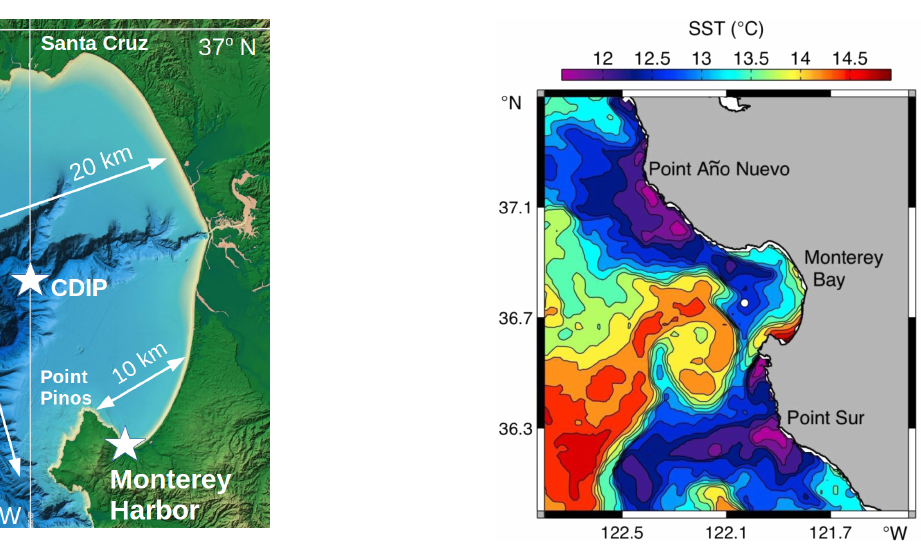
Figure 2. Sea surface temperature image from 13 October 2008 de- picting the persistent mesoscale anti-cyclonic gyre offshore of Mon- terey Bay. Image from Ryan et al.